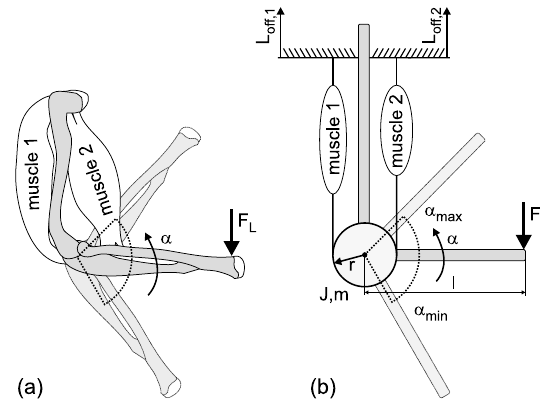
Fig.1. (a)Simplifieddepictionofthehumanarmwithanelbowjoint moved by two muscles. (b) Model of the antagonistic joint setup in